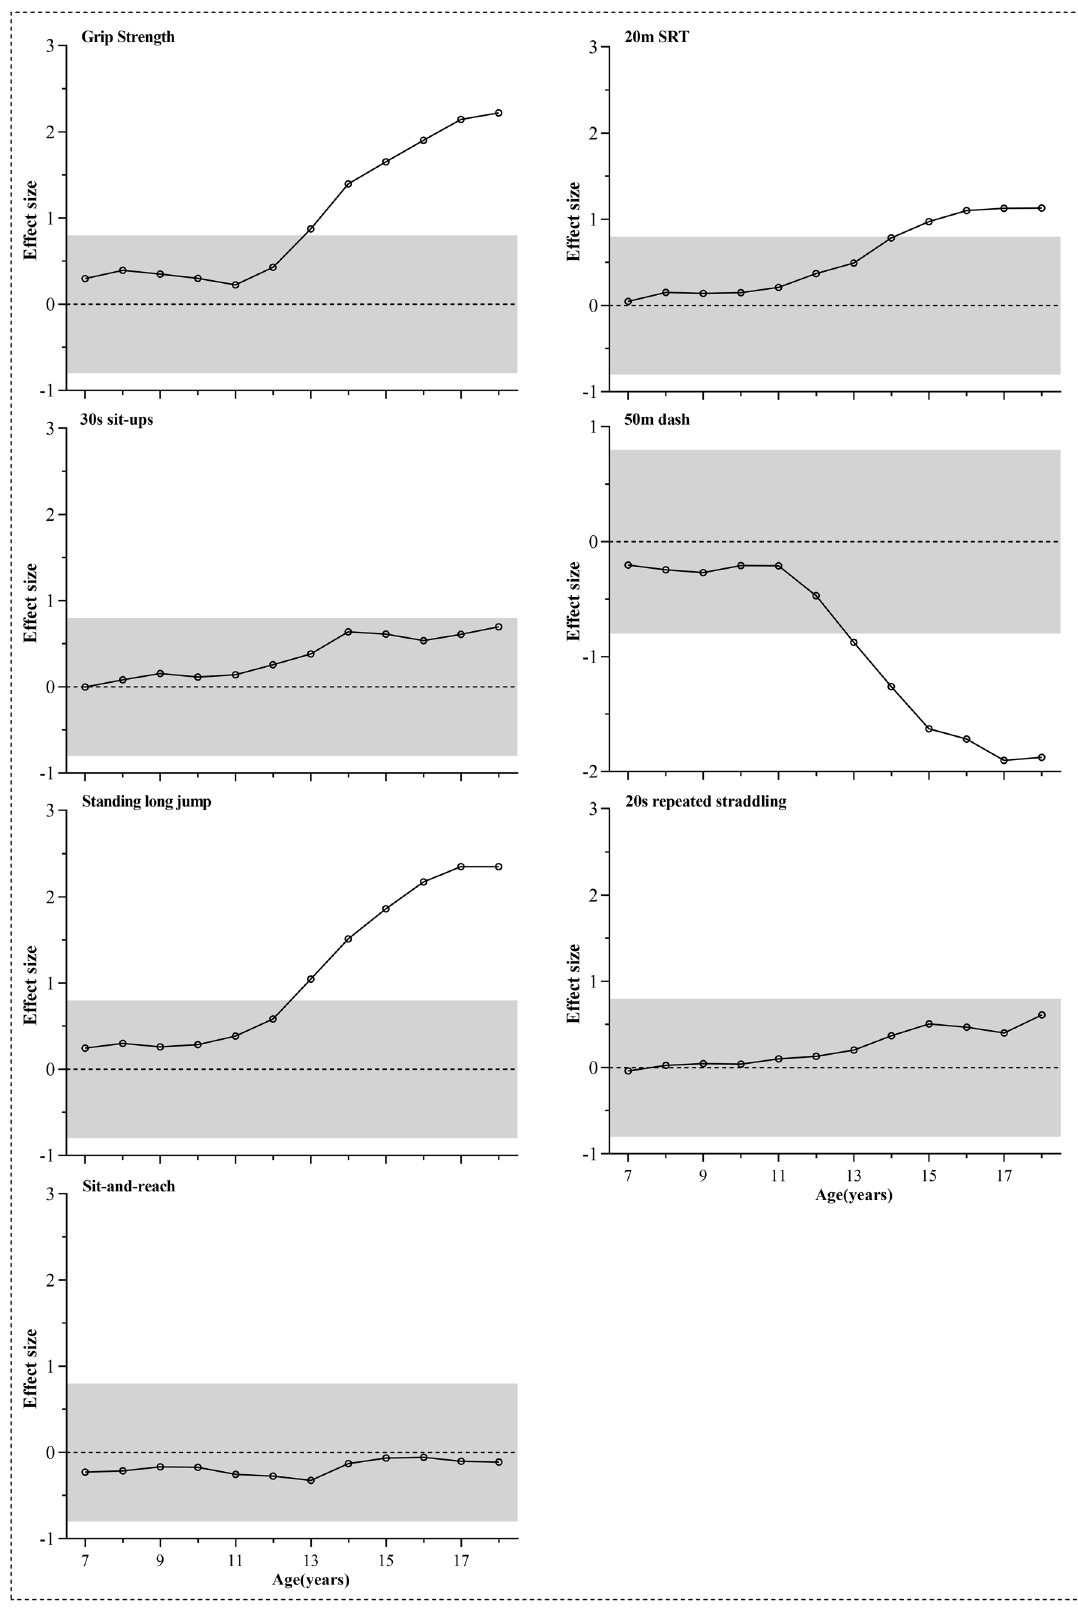
Figure 3. Sex-related difference in each physical fitness test (( A ) grip strength, ( B ) 20-m SRT, ( C ) 30-s sit-ups, ( D ) 50-m dash, ( E ) standing long jump, ( F ) 20-s repeated straddling, ( G ) sit and reach) expressed as standardized effect sizes (anchored to girls = 0). The limits of the grey zone represent the threshold for a large standardized difference (i.e., 0.8 or − 0.8). Positive effect sizes indicated that mean fitness test performances for boys were higher than those for